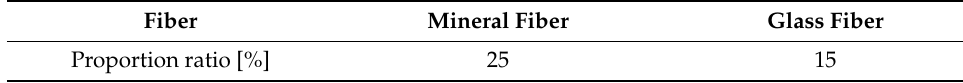
Table 1. The proportion of glass fiber and mineral fiber in PA6.